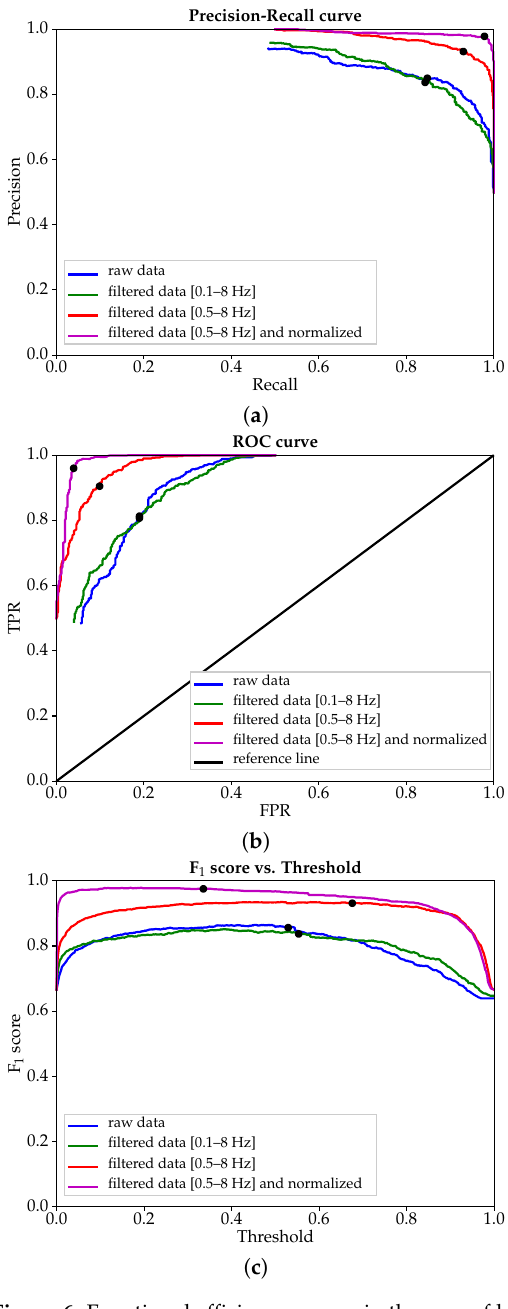
Figure 6. Functional efficiency curves in the case of leaving 40% of data out of training. The working points of the EER curve (see Figure 5) are tagged with the symbol • : ( a ) precision-recall curve; ( b ) ROC curve; ( c ) F 1 score–threshold